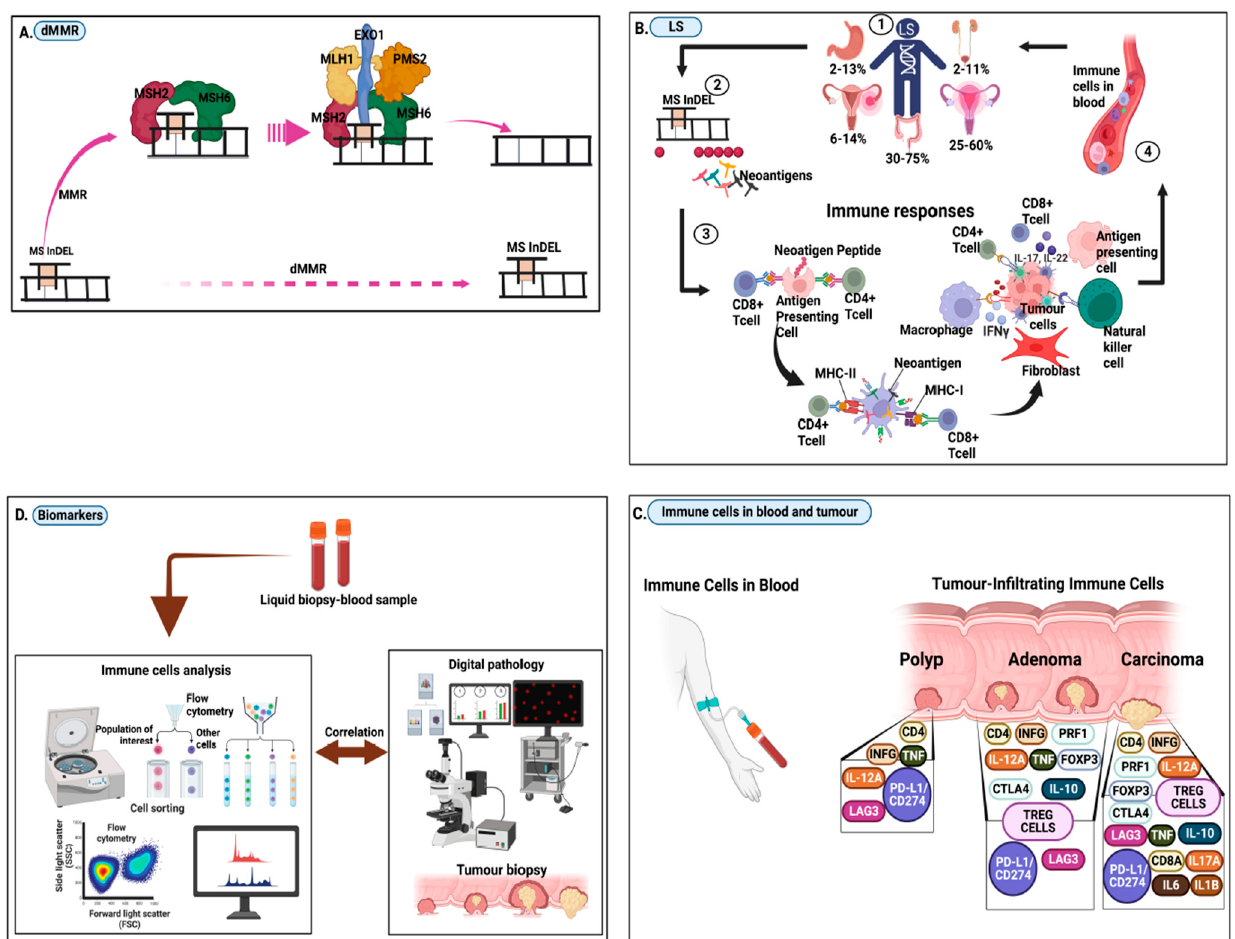
Figure 1. Schematic illustration of pathogenesis and characterisation of immunogenomic biomarkers in blood. ( A ) Deficiency in mismatch repair (dMMR) occurs when the microsatellite (MS) indel is not repaired by MMR genes. ( B ) LS, which occurs due to dMMR. When MS indels are not repaired in LSVH, frameshift neopeptides are formed and accumulate on the cell surface and in the bloodstream as neoantigens. These neoantigens trigger immune responses that accumulate in the circulation and infiltrate the neoplasm during early carcinogenesis. ( C ) Immune cells (including pro-inflammatory and checkpoint molecules) in blood and tumour-infiltrating cells correlating with different neoplasm/tumour stages ( D ) Immunogenomic biomarker analysis to detect cellular and acellular immune components in blood. Biomarker profiles correlated with clinical parameters in digital pathology results for cancer diagnosis and prognosis assessments.